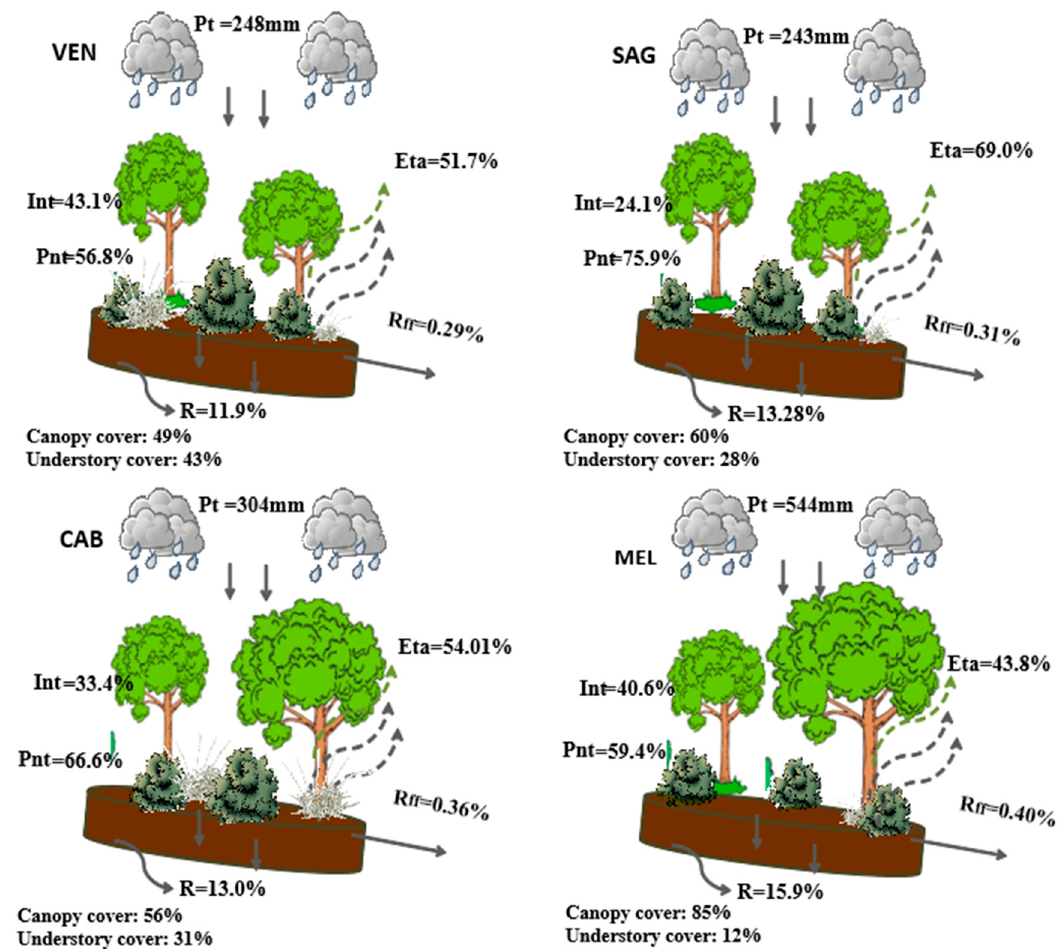
Figure 2. Water balance diagrams in the different forests along a gradient of precipitation. The water flow values estimated by the HYDROBAL ® model according to the pine afforestation obtained at each site. Values are a percentage (%) in relation to total precipitation. Abbreviations: Net precipitation (Pnt); Interception (Int); Runoff (Rff); actual evapotranspiration (Eta); potential recharge (R). Site names: Ventós (VEN); Sierra de Águilas (SAG), Cabeço d’or (CAB); Mela (MEL).